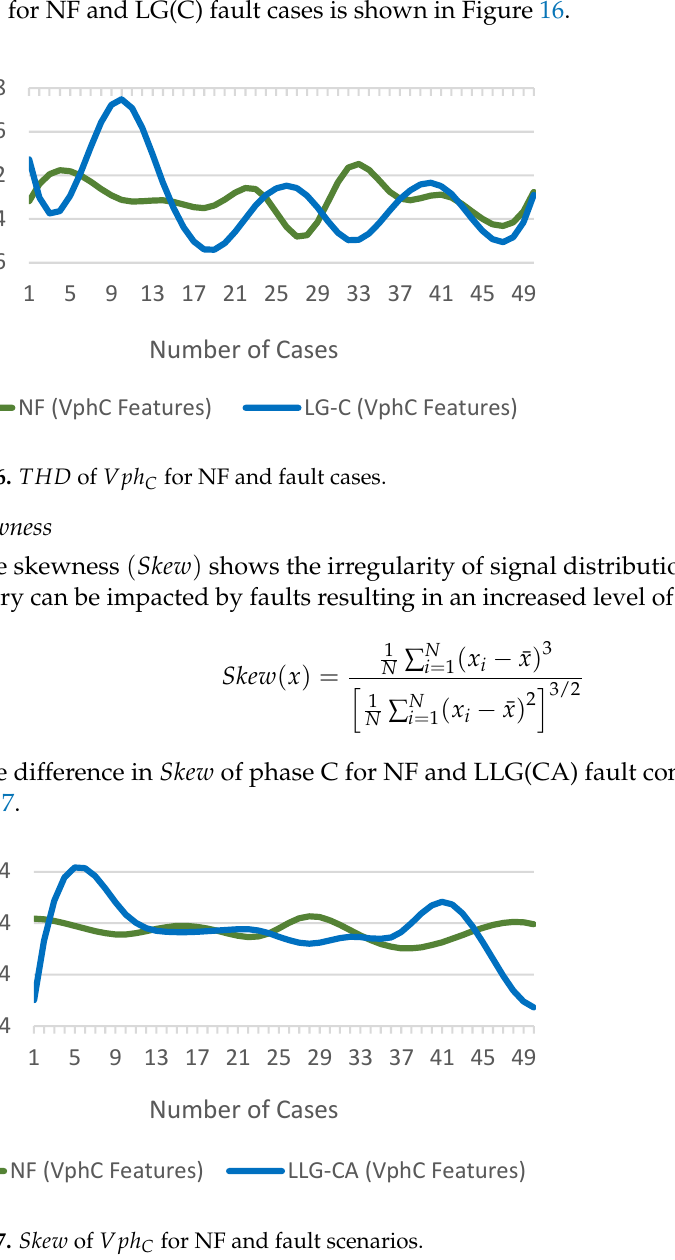
Figure 17. Skew of Vph C for NF and fault